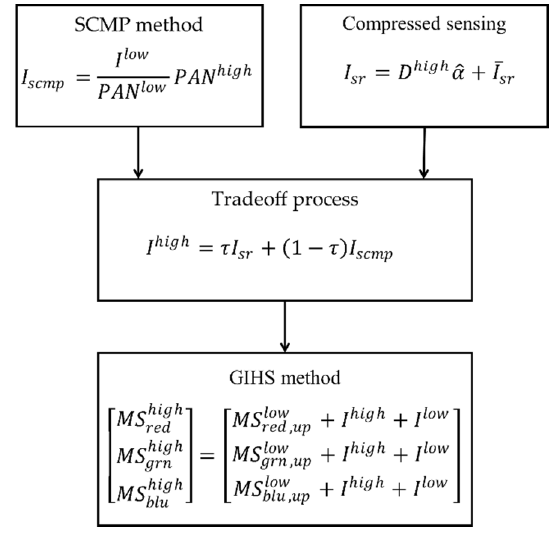
Figure 1. Flow of the proposed method.